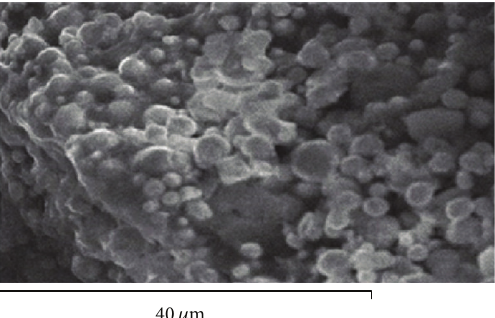
Figure 11: Scanning tunneling microscopy image of zinc sol.